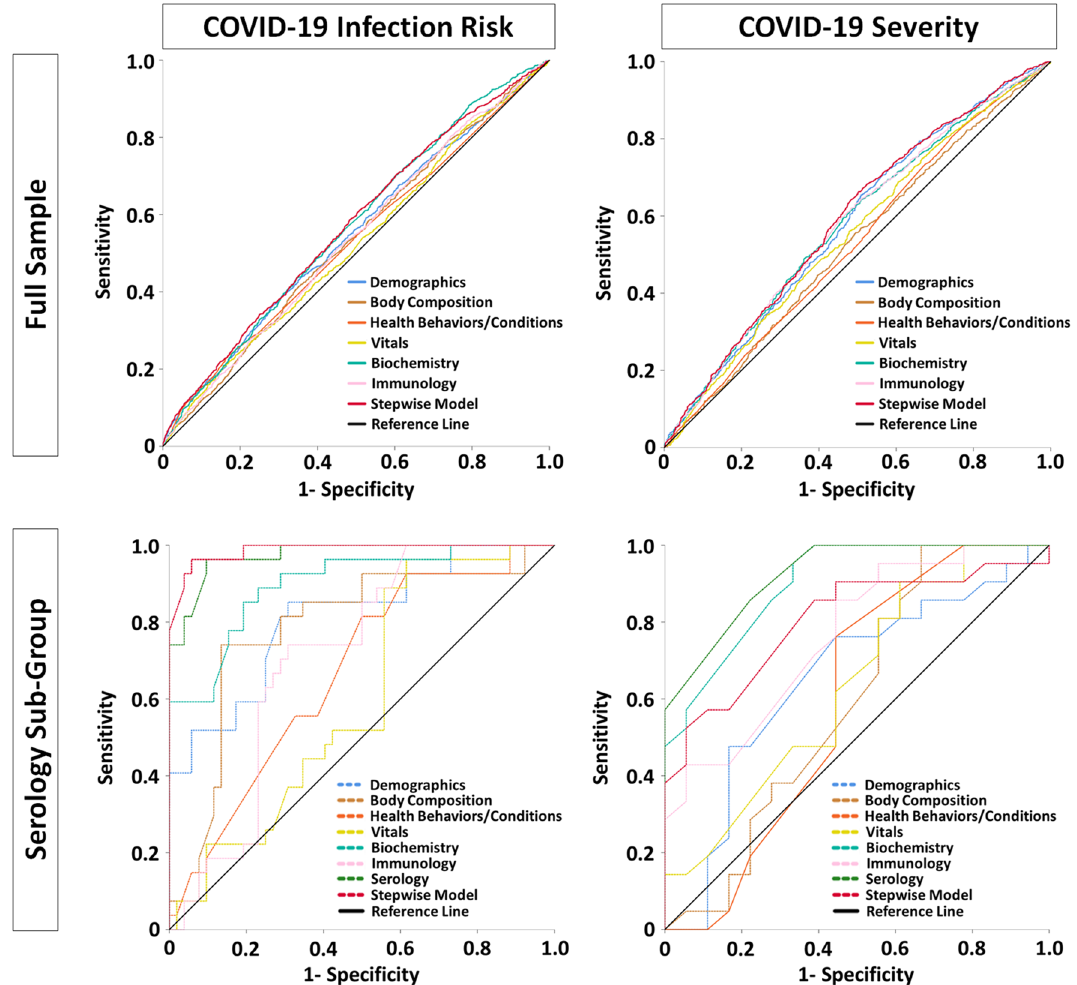
Figure 1. Receiver Operating Characteristics (ROC) curves illustrating the relative classifier performance of various sets of predictors. Outcomes of interest were COVID-19 infection risk and whether an infection was mild or severe. Two separate sets of analyses were done for the full tested sample and a sub-group of participants with serology data. Test statistics for predictors are provided in Tables 3 and